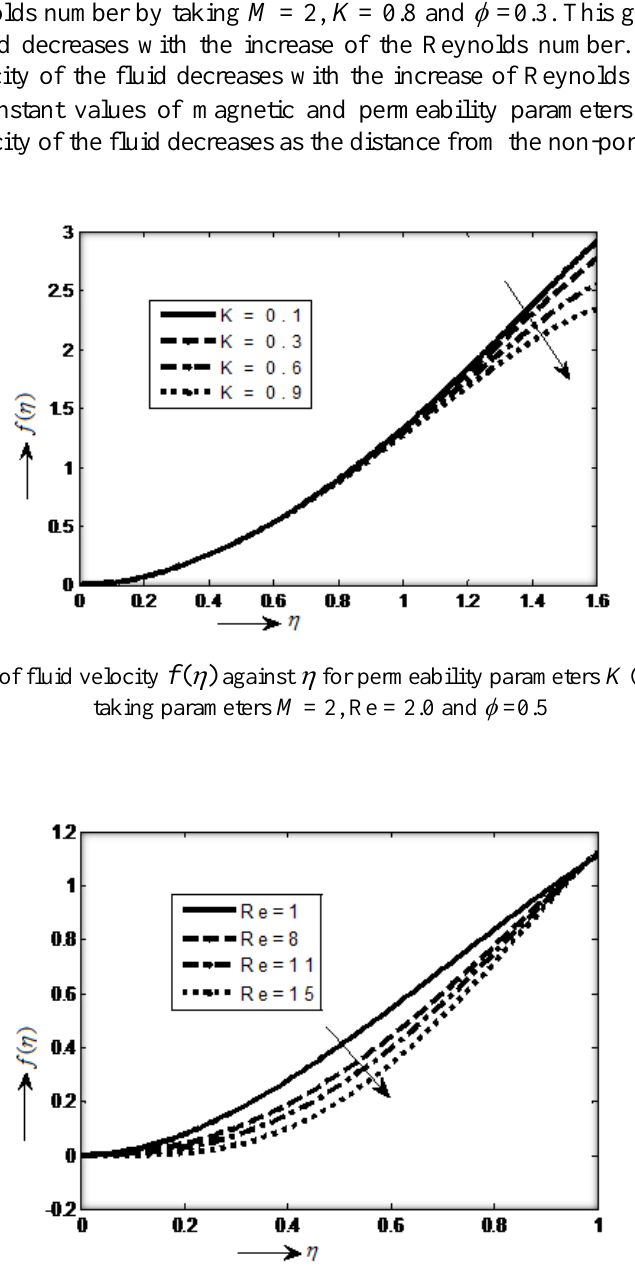
Figure 3.Variation of fluid velocity f (  ) against  for Reynolds Number Re (1, 8, 11, 15) by taking parameters M = 2, K = 0.8 and 